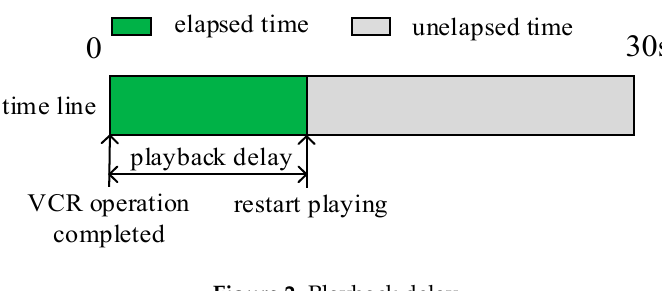
Figure 2. Playback delay.